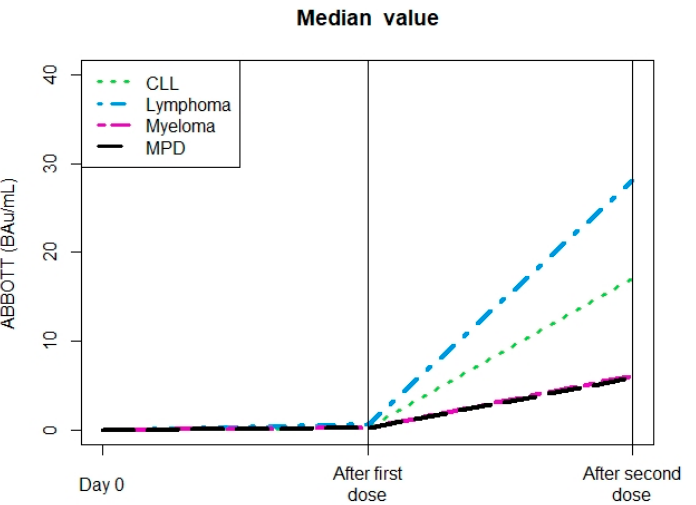
Figure 1. Median levels of anti-spike antibodies: comparison between the first and second doses. Abbreviations: CLL: Chronic lymphocytic leukemia; MPD: myeloproliferative disorders. Abbreviations: CLL: Chronic lymphocytic leukemia; MPD: myeloproliferative